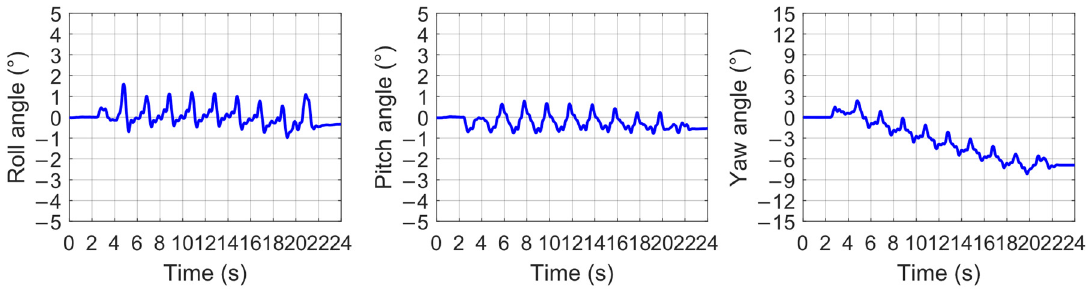
Figure 14. Attitude variations in tripod gait (no correction).